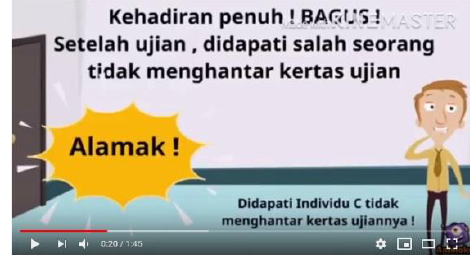
Figure 4: Examination answer script losing case